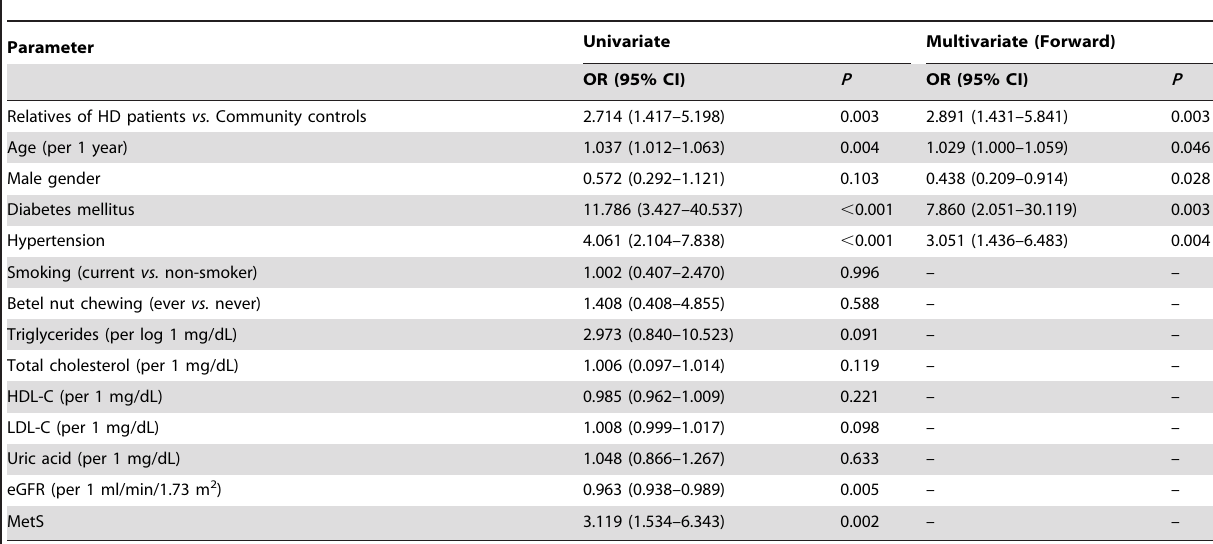
Table 3. Determinants of albuminuria in all subjects.